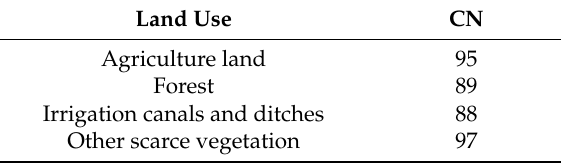
Figure 10. Land use of Jiaohe County